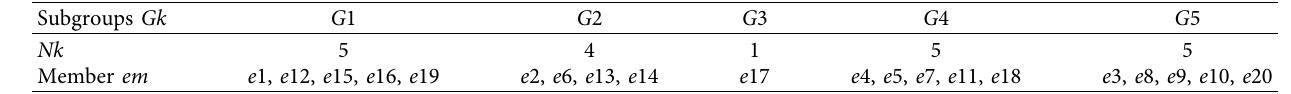
Table 1: .e clustering